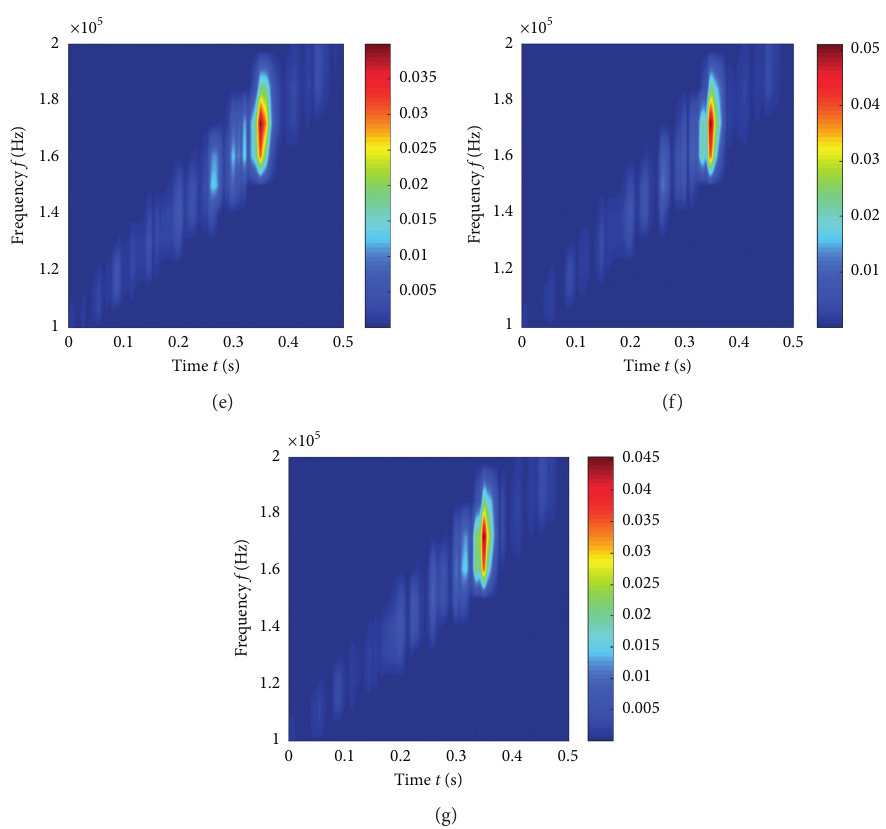
Figure 6: STFT time-frequency diagram, (a) day 1, (b) day 5, (c) day 9, (d) day 13, (e) day 19, (f) day 25, and (g) day 28.